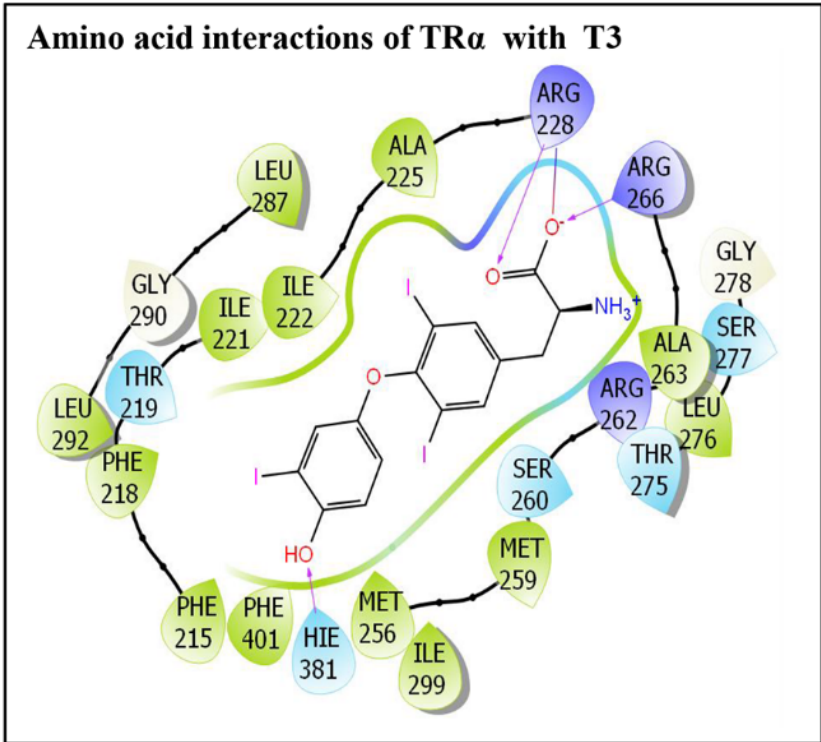
Figure 3. The molecular interactions of a triiodothyronine (TR α ) native ligand and triiodothyronine (T3) with residues lining TR α ligand-binding pocket.